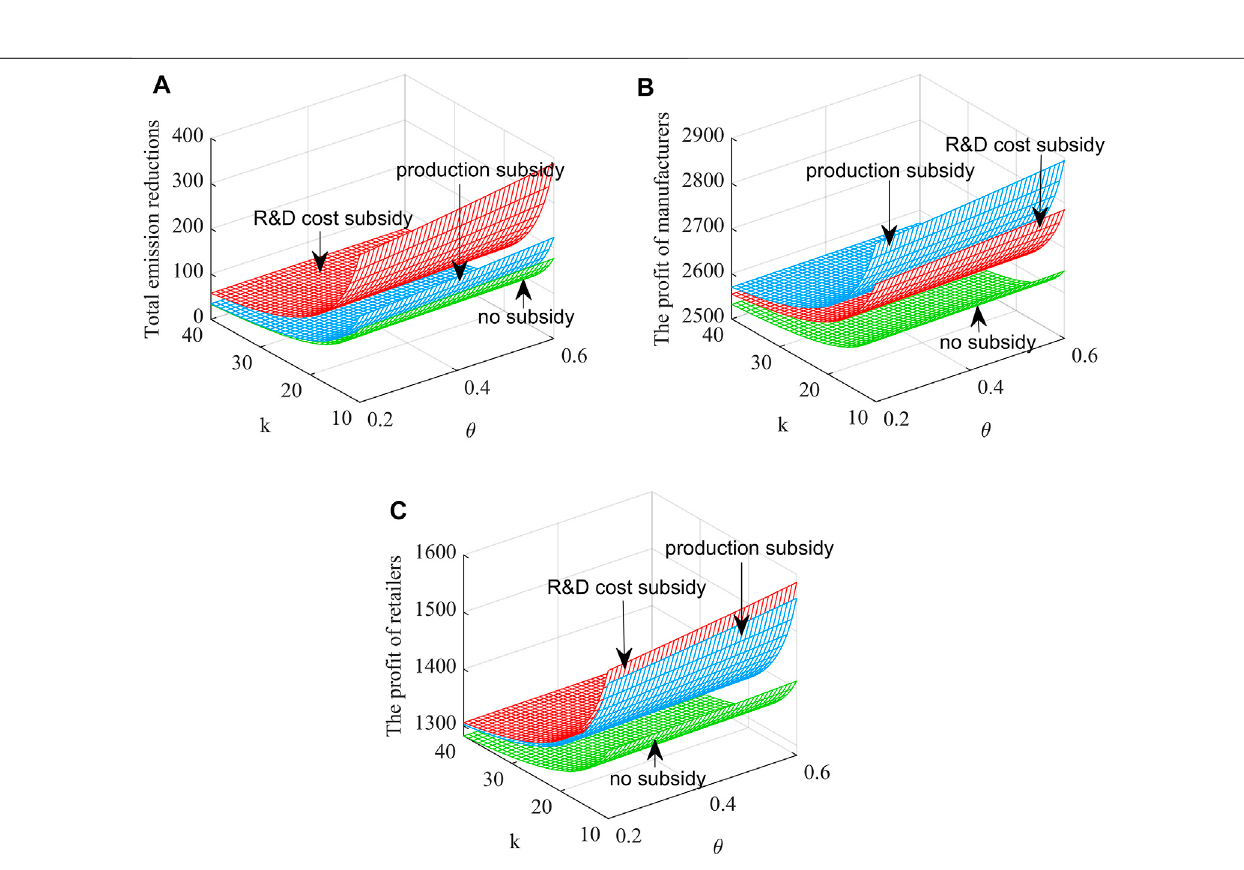
Frontiers in Environmental Science |